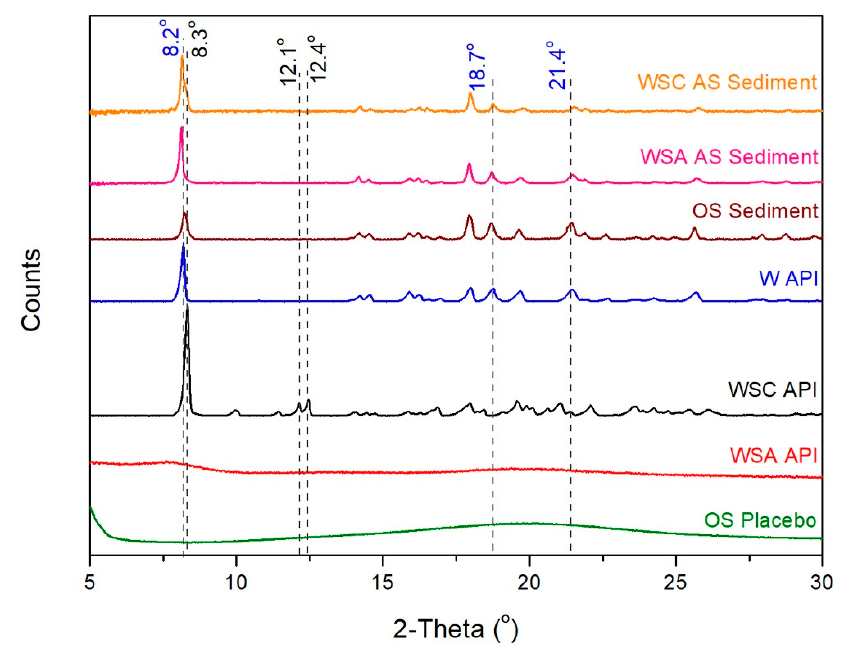
Figure 4. XRPD patterns of the sediment obtained from the aqueous solution of warfarin sodium clathrate (WSC AS), the sediment obtained from the aqueous solution of warfarin sodium amorphous (WSA AS), oral suspension (OS) sediment, warfarin (W) API, warfarin sodium clathrate API, warfarin sodium amorphous API, and oral suspension placebo.